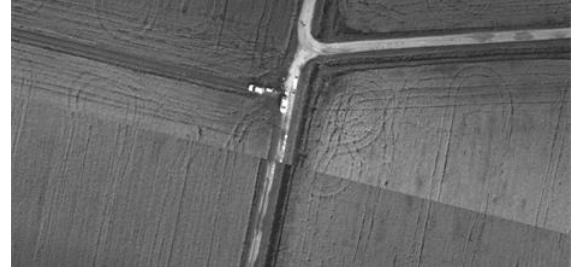
Figure 3. An excerpt of the green orthophoto in the overlapping area; a significant planimetric displacement is evident